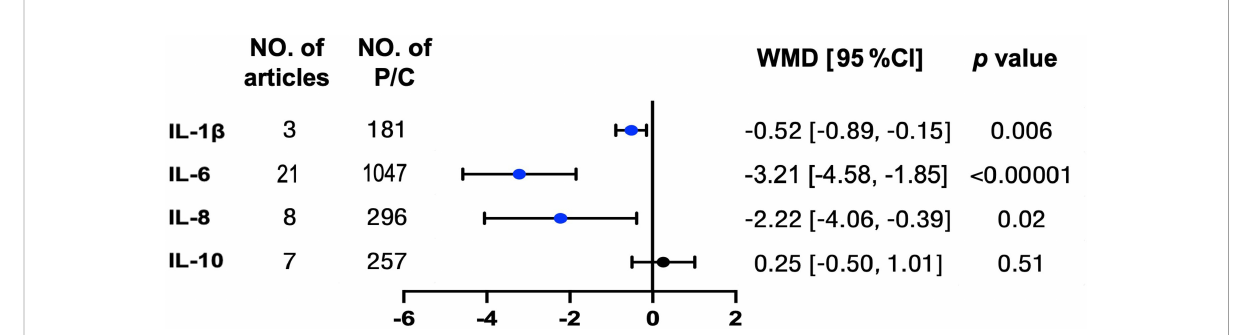
FIGURE 3 Typical in fl ammation but not anti-in fl ammation interleukins were reduced in patients with OSA after treatments. Concentrations for above interleukin proteins were tracked from pre-treatment to post treatment in patients with OSA. The unit for protein concentrations was presented as picograms per milliliter. Weighted mean difference (WMD) and 95% con fi dence interval (95% CI) were used for analysis. No. of articles, number of articles included for analysis in each group. No. of P, number of patients with OSA (P) included for each group. The statistically